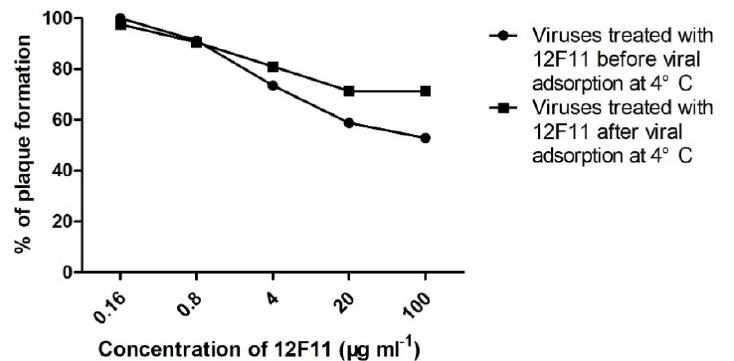
Figure 6. Neutralization of TMUV Y by treatment with MAb 12F11 in pre- and post-adsorption inhibition assays. TMUV Y was incubated with different dilutions of 12F11 before ( ● ) or after ( ■ ) viral adsorption at 4 °C. The results shown are a percentage of plaque formation.